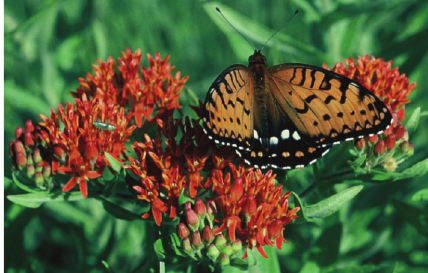
Figure 1: Dorsal view of a Regal Fritillary nectaring on Butterfly Milkweed ( Asclepias tuberosa ) in Missouri, USA, showing the submarginal row of orange spots on the hindwing in males (white in females). Photo by Ann B. Swengel.